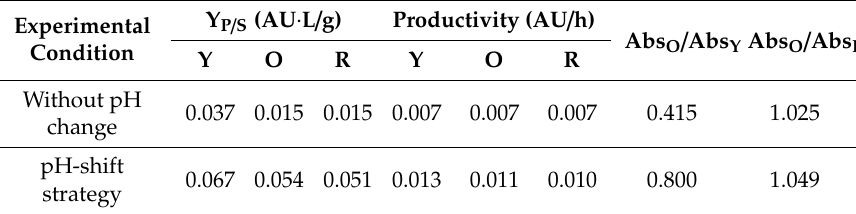
Table 1. Kinetic parameters calculated for substrate conversion factor (sucrose) in product (Y P / S ) and productivity during the submerged cultivation of T. amestolkiae in a stirred-tank bioreactor for the production of yellow (Y, AU 400nm ), orange (O, AU 470nm ), and red colorants (R, AU 490nm ) without a pH change and after a pH-shift from 4.5 to 8.0 at 96 h of